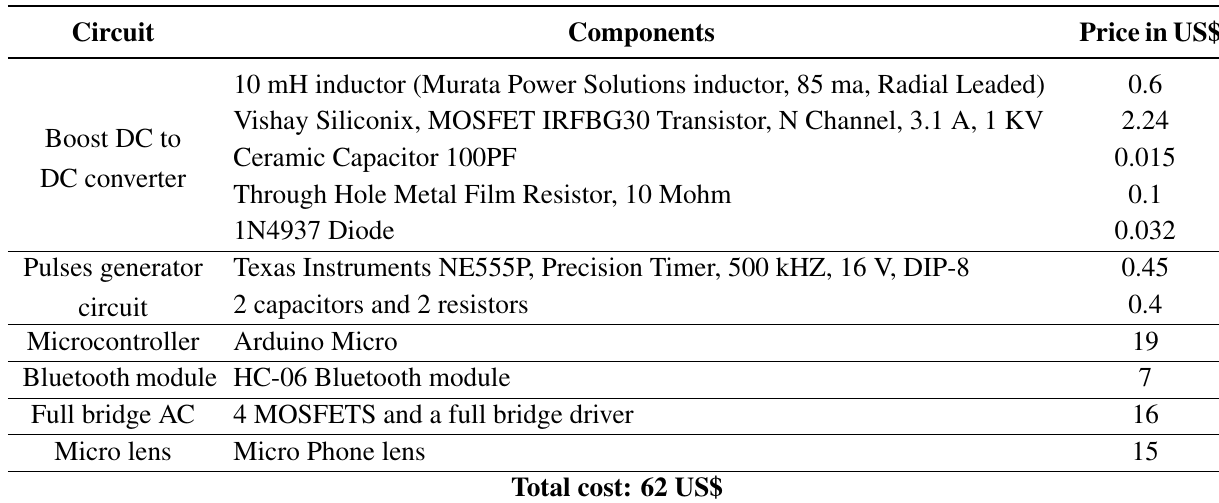
Figure 8. The final prototyped portable DMF modular platform. Table 1. The cost of the components of the